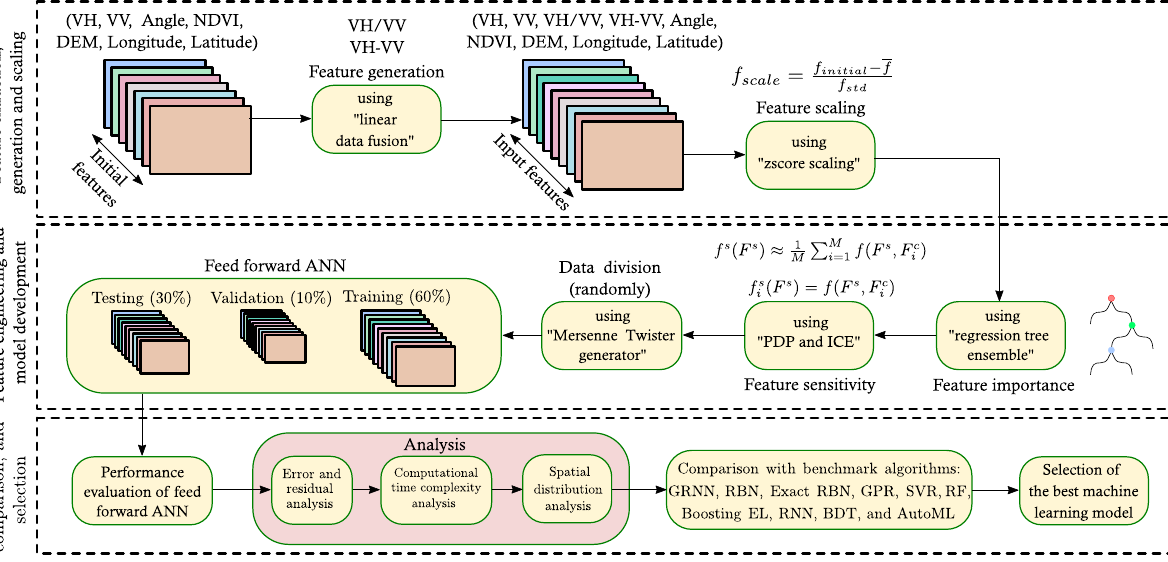
Figure 4. Flowchart illustrates the detailed